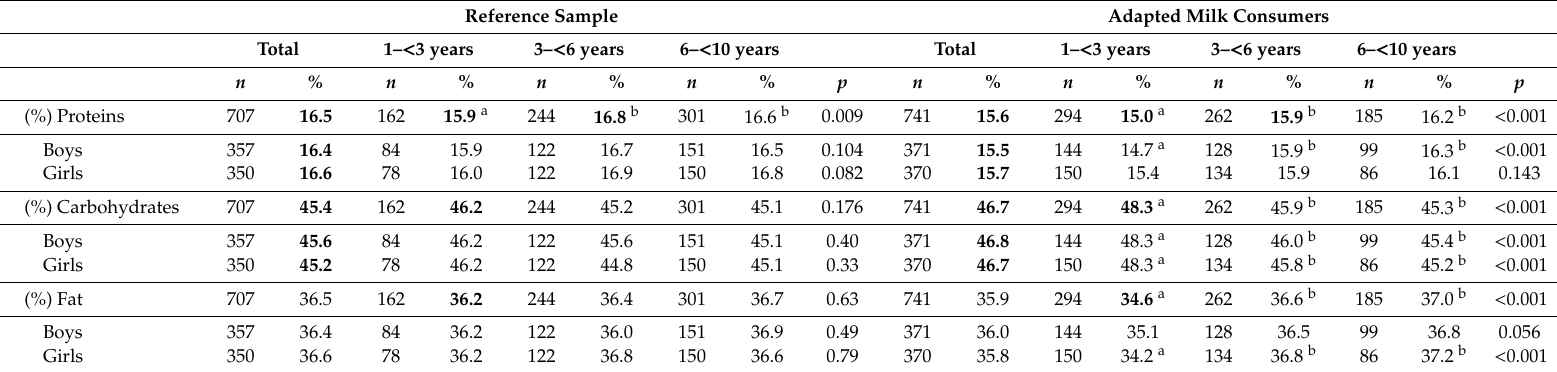
Table 4. Distribution of reported intakes of macronutrients as a percentage of the total energy intake (%EI) from two 24-h dietary recalls from the Nutritional Study in Spanish Pediatric Population (EsNuPI) according to sex and age group ( n =